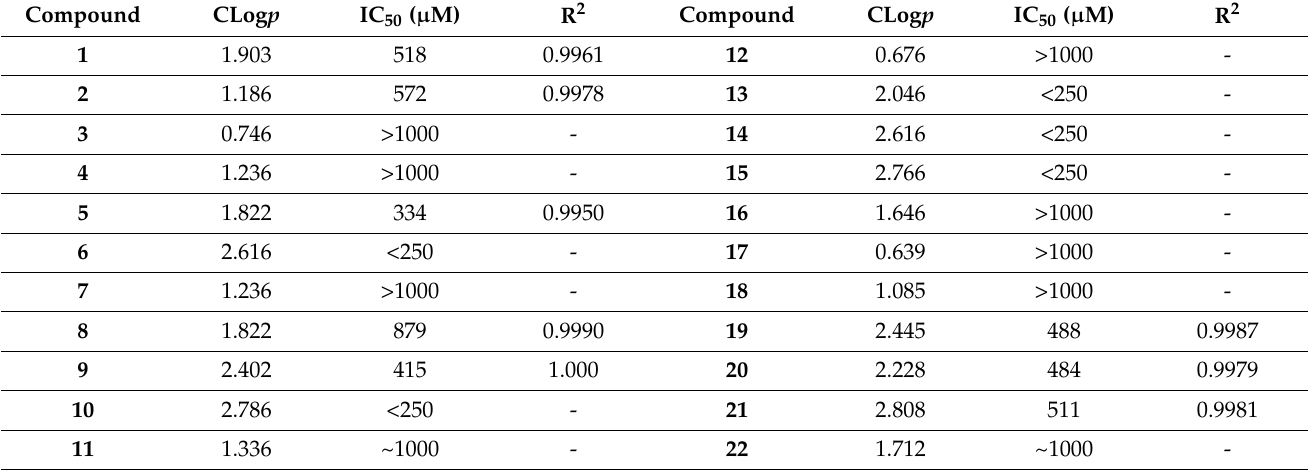
Table 1. IC 50 and CLog p values of compounds 1 – 22 , ~1000, inhibition was close to 50% at the highest tested concentration; >1000, compound was far from 50% inhibition at the highest concentration tested but activity was significant; <250, IC 50 was lower than the lowest tested concentration.